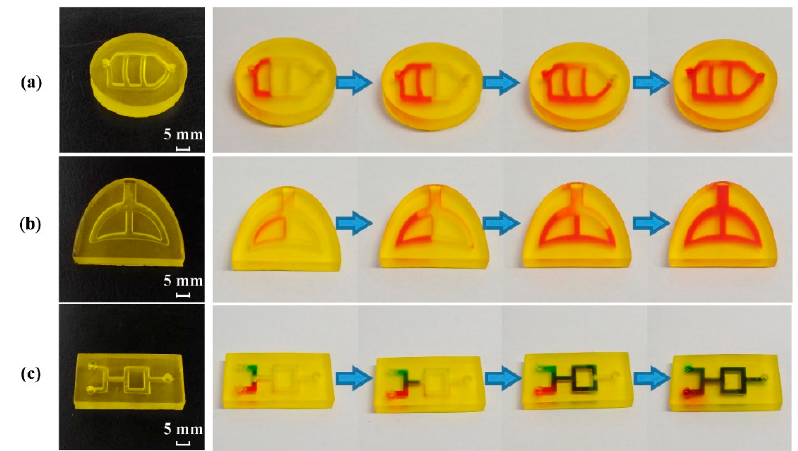
Figure 12. Printed samples with internal channels and their perfusion process: ( a ) vascular model, ( b ) tracheal model, and ( c ) fluid mixing model.